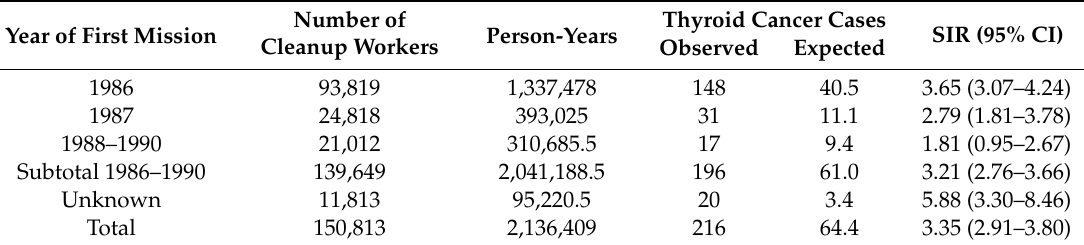
Table 2. Number of thyroid cancer cases, person-years of observation, and SIR in the cohort of male Ukrainian cleanup workers (150,813) by year of first mission in the Chornobyl zone